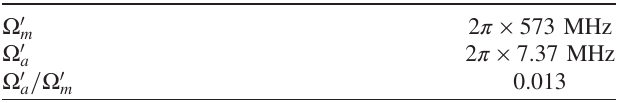
TABLE II. The effective Rabi frequencies for the v 0 ¼ 0 state of c 3 Σ þ 1 at 3.75 mW of tweezer